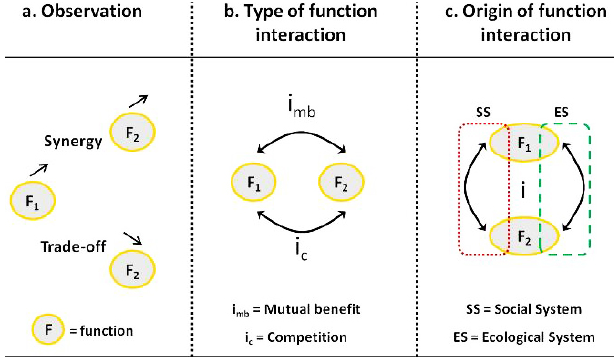
Fig. 3 . Different steps explaining the observed relations between social-ecological systems